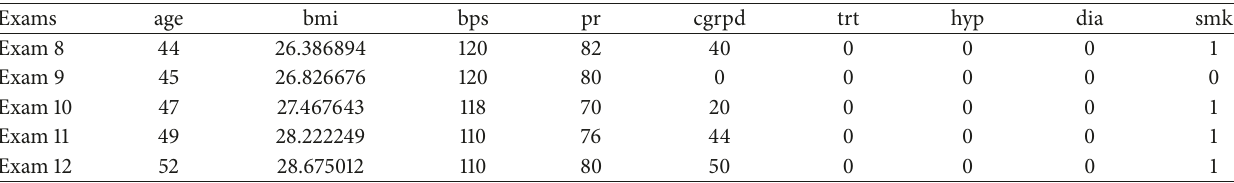
Table 8: Exam data for Sample 1: male without CVD.